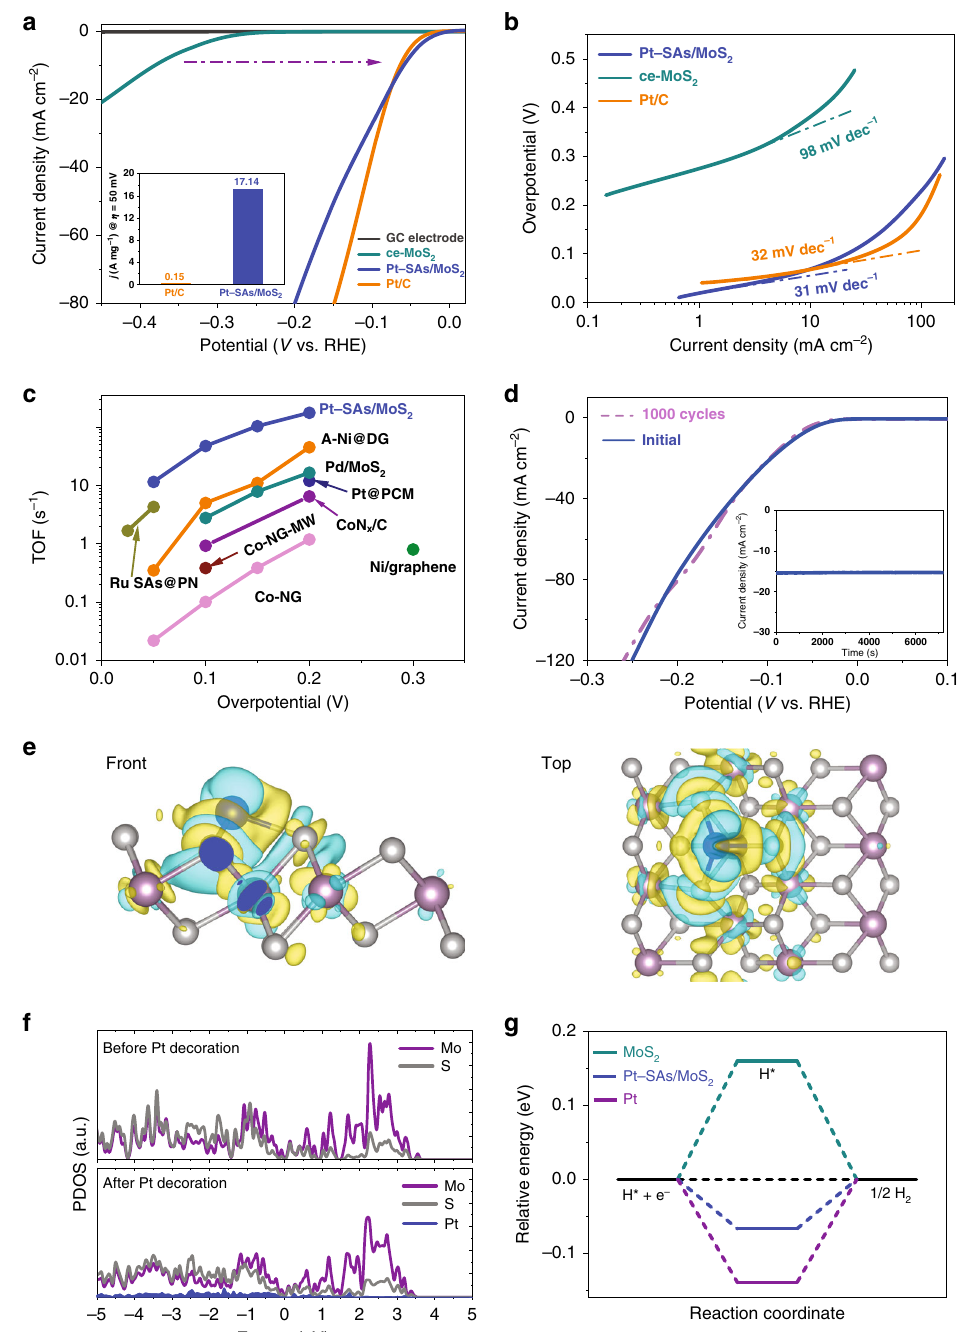
Fig. 4 Electrocatalytic performance of the Pt-SAs/MoS 2 catalyst in the HER. a HER polarization curves of bare, ce-MoS 2 -, commercial Pt/C-, and Pt-SAs/MoS 2 -covered GC electrodes in 0.5 M H 2 SO 4 solution. Inset: the mass activity of Pt-SAs/MoS 2 normalized to the Pt loading at an overpotential of 50 mV in comparison with commercial Pt/C. b Tafel plots derived from the corresponding polarization curves. c The turnover frequency (TOF) curve of Pt-SAs/MoS 2 and a comparison with previously reported data for single-atom HER catalysts. d Stability test of Pt-SAs/MoS 2 by potential cycling before and after 1000 cycles. Inset: time-dependent current density curve of Pt-SAs/MoS 2 obtained at a constant overpotential of η = 80 mV for 2 h in 0.5 M H 2 SO 4 solution. e Front (left) and top (right) views of the differential charge density of Pt-SAs/MoS 2 . The yellow and blue surfaces correspond to gain and loss of charge, respectively. f Calculated PDOS of MoS 2 and Pt-SAs/MoS 2 with aligned Fermi levels at 0 eV. g Calculated the free energy diagram of the HER at the equilibrium potential for MoS 2 , Pt-SAs/MoS 2 , and Pt (pH